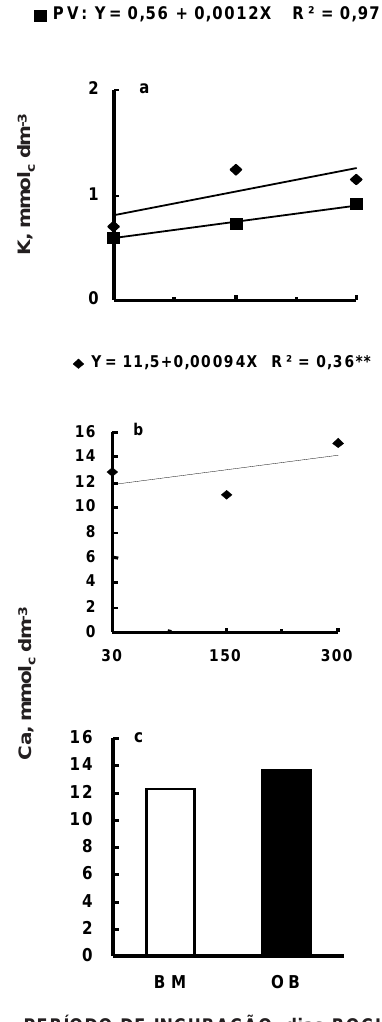
Figura 2. Concentração de K e de Ca trocáveis no solo. a: Média de doses e de rochas, aos 30, 150 e 300 dias de incubação, no Latossolo Vermelho- Escuro (LEd) e no Podzólico Vermelho-Amarelo (PV). b: Média de doses, de solos e de rochas, aos 30, 150 e 300 dias de incubação. c: Média de doses, solos e períodos de incubação, obtidos com o basalto microcristalino (BM) e com olivina- basalto